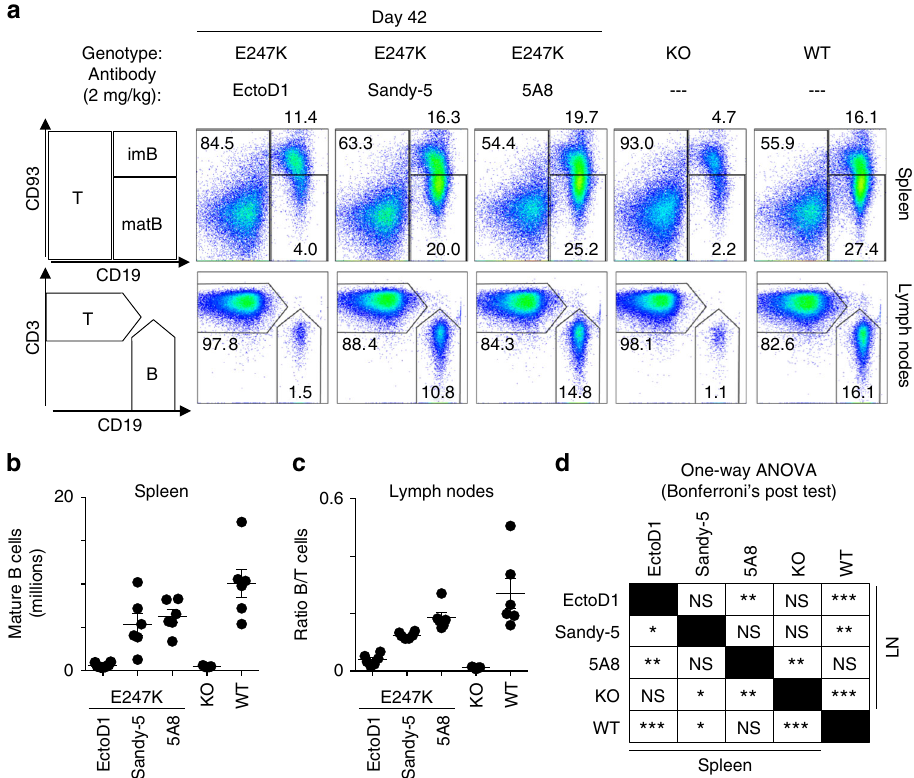
Fig. 5 Restoration of mature B cells in BAFF E247K knock-in mice treated with cross-linking anti-mBAFF antibodies. Cohorts of BAFF E247K knock-in mice received control (EctoD1) or BAFF cross-linking antibodies (Sandy-5 or 5A8) weekly for 6 weeks, then spleen and lymph nodes were analyzed for the presence of mature B cells. Groups of untreated wild type (WT) and BAFF knock-out (KO) were analyzed in parallel. a Flow cytometry analysis of spleen (top dot plots) and lymph nodes (bottom dot plots). Cell populations analyzed are shown on the left. imB: immature B cells; matB: mature B cells. b Same as panel a , but showing number of B cells in spleens of 6 mice per group (5 mice for KO). Mean ± SEM. For statistics, see panel d . c Same as panel b , but showing B to T cell ratio in lymph nodes. For statistics, see panel d . Experiment of panels a – c was performed once in this format (and once with 5A8 in two ki mice, looking at kinetics of successful B cell restoration in blood). d Results of one-way Anova followed by Bonferroni multiple comparison test for mature B cells in the spleen (lower left half) and B/T cell ratio in lymph nodes (upper right half). NS = not signi fi cant: p > 0.05; * p < 0.05; ** p < 0.01; *** p < 0.001. Panels b – d : results of statistical test should be considered with caution because although most measures were distributed normally, the assumption of equal variance between groups was not met. See also Supplementary Table